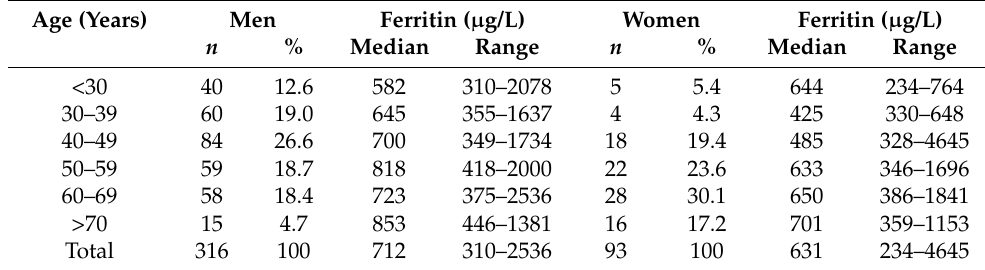
Table 2. Ferritin levels at age split in